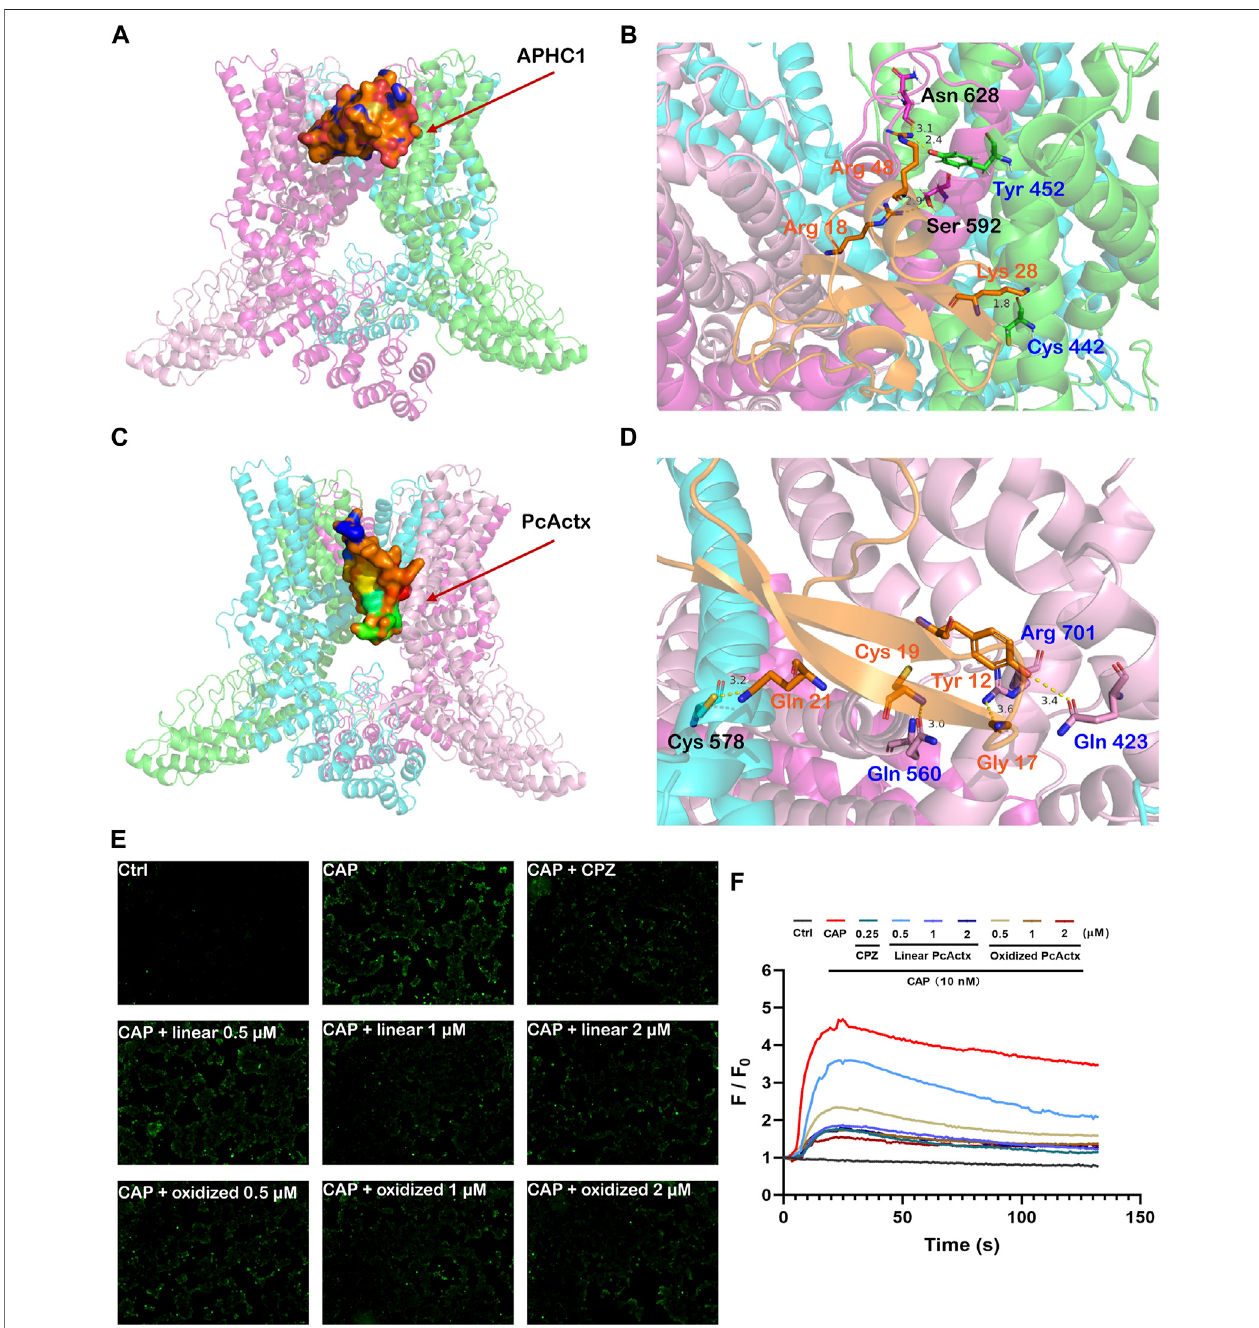
FIGURE4| Peptide-proteindockinganalysisand fl uorescentcalciummeasurement. (A) .Sideviewofprotein-peptidedockingoftheAPHC1peptidebindingtothe TRPV1channel.Thepeptideisshownasaribbondiagramcoloredinorange;theproteinisshownasacartoon. (B) .InterfaceresiduesbetweenAPHC1peptideandthe TRPV1 channel. APHC1 peptide is shown in orange cartoon. In α chain, the hydrogen bonds are formed by Arg 18 and Arg 48 of APHC1 peptide with residue Ser 592 and Asn628,respectively.In β chain,thehydrogenbondsareformed byLys28and Arg48ofAPHC1peptidewithresidueCys442andTry453,respectively. (C) . Side view of protein-peptide docking of the PcActx peptide binding to the TRPV1 channel. The peptide is shown as a ribbon diagram colored in orange; the protein is shown as a cartoon. (D) . Interface residues between PcActx peptide and the TRPV1 channel. PcActx peptide is shown in orange cartoon. The hydrogen bonds are formed by Tyr12, Gly17, Cys19, and Gln21 of PcActx peptide with residue Gln423, Arg701, Gln560 in γ chain, and Cys578 in δ chain of TRPV1, respectively. (E) . Representative images of intracellular calcium concentration of HEK293-hTRPV1 cell (CAP: capsaicin; CPZ: capsazepine). (F) . Representative time-dependent response of Ca 2+ fl uorescence intensity in each group. Ca 2+ responses were measured as changes in fl uorescence intensity of the representative average plots (n (cid:2) 5) before (F 0 ) and after capsaicin addition (F). (E,F) graphs represent a single representative experiment from a total of three independent experiments.